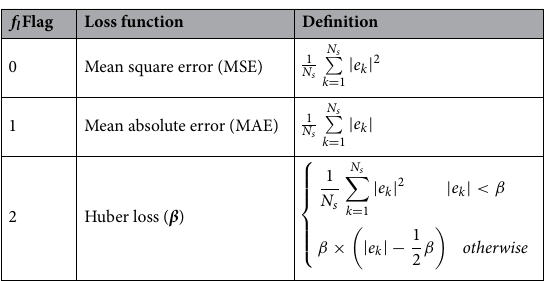
Table 2. Loss functions employed by FARM